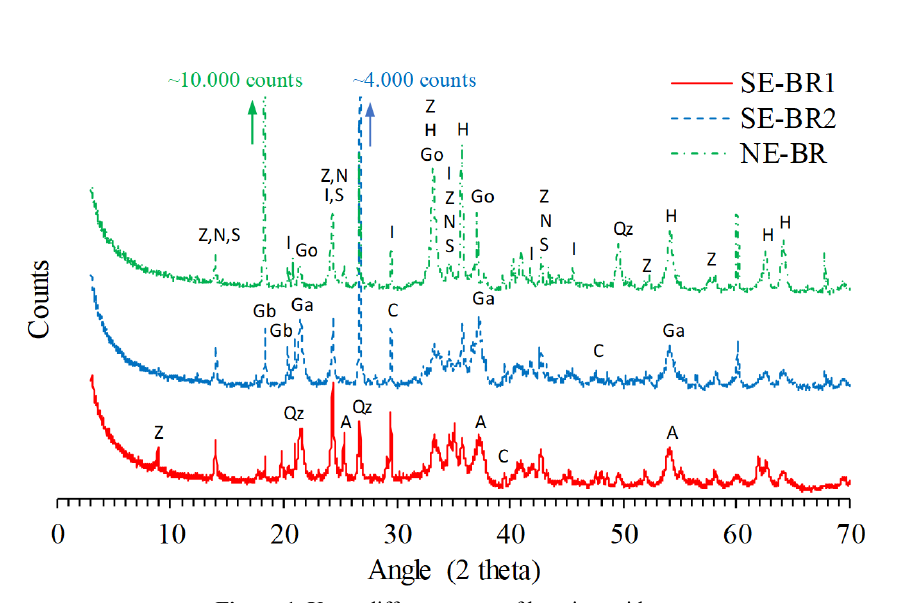
Figure 1. X-ray diffractograms of bauxite